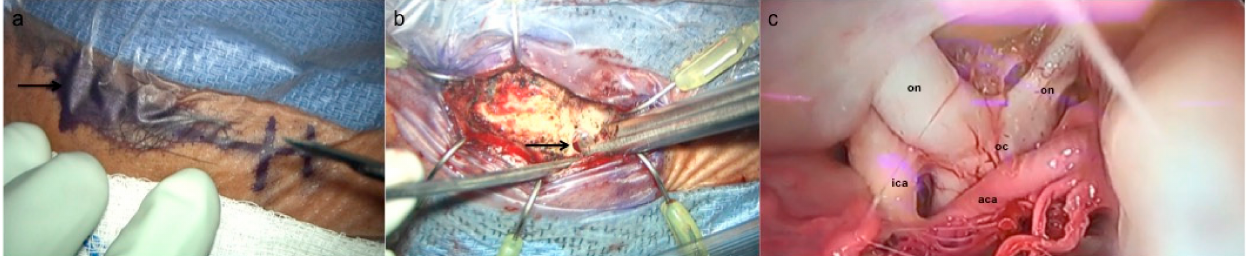
Figure 3. Intra-operative images from a supraorbital craniotomy. ( a ) The planned incision is illus- trated, beginning just lateral to the supraorbital notch (arrow) within the eyebrow and extending laterally. ( b ) After inferior reflection of the orbicularis and temporalis muscle flap, a burr hole is made at the keyhole (arrow) and further widened with a rongeur. ( c ) A endoscopic cadaver view demonstration of the supraorbital approach to the suprasellar area. The internal carotid artery, optic nerves, optic chiasm, and the anterior cerebral arteries are shown. Abbreviations: aca (anterior cerebral artery), ica (internal carotid artery), oc (optic chiasm), on (optic